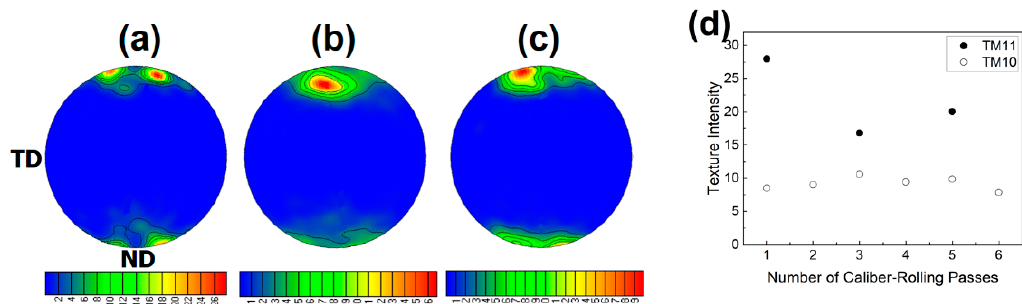
Figure 6. {0001} pole figure maps of TM11 Mg alloys: ( a ) TM11-1P, ( b ) TM11-3P, and ( c ) TM11-5P; ( d ) texture intensities of the investigated TM10 and TM11 Mg alloys.